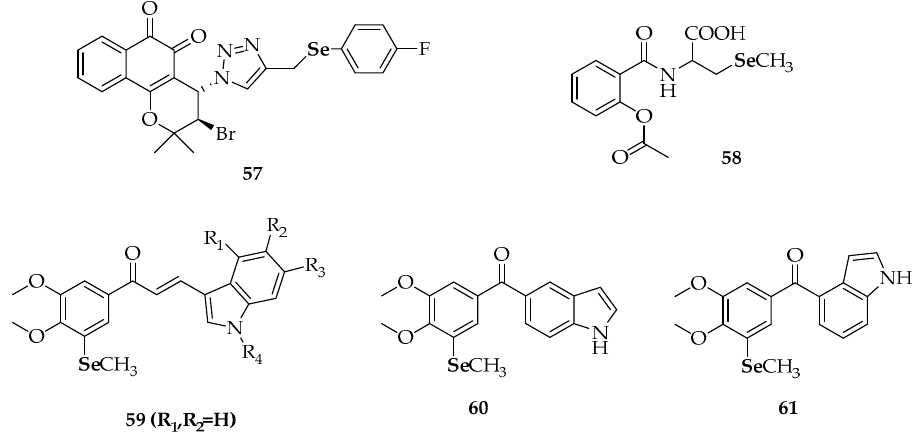
Figure 7. Synthetic selenides with antitumoral studies [91–95].